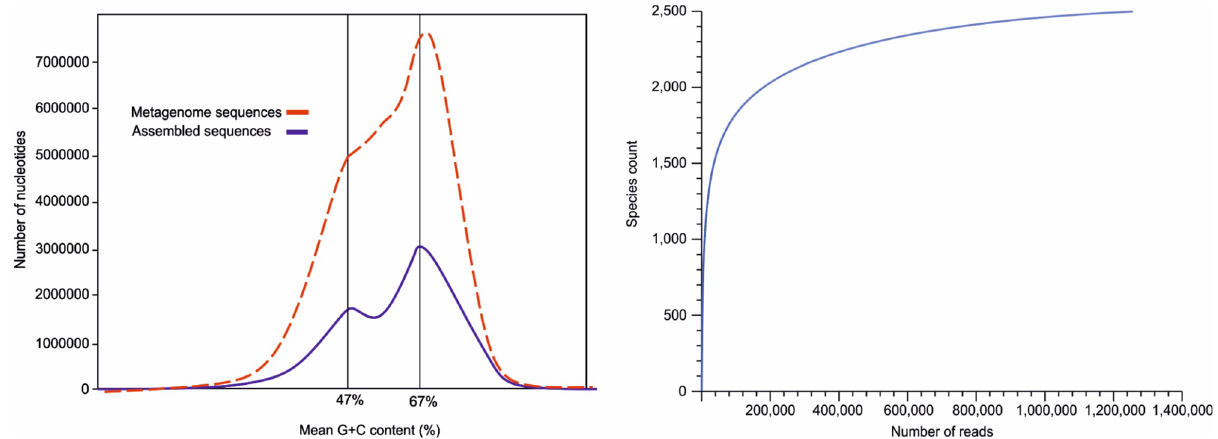
Figure 2. Percentage of the G+C content of the raw reads and assembled metagenome sequences (left). Rarefaction plot of the phylogenetic diversity of the metagenomic reads